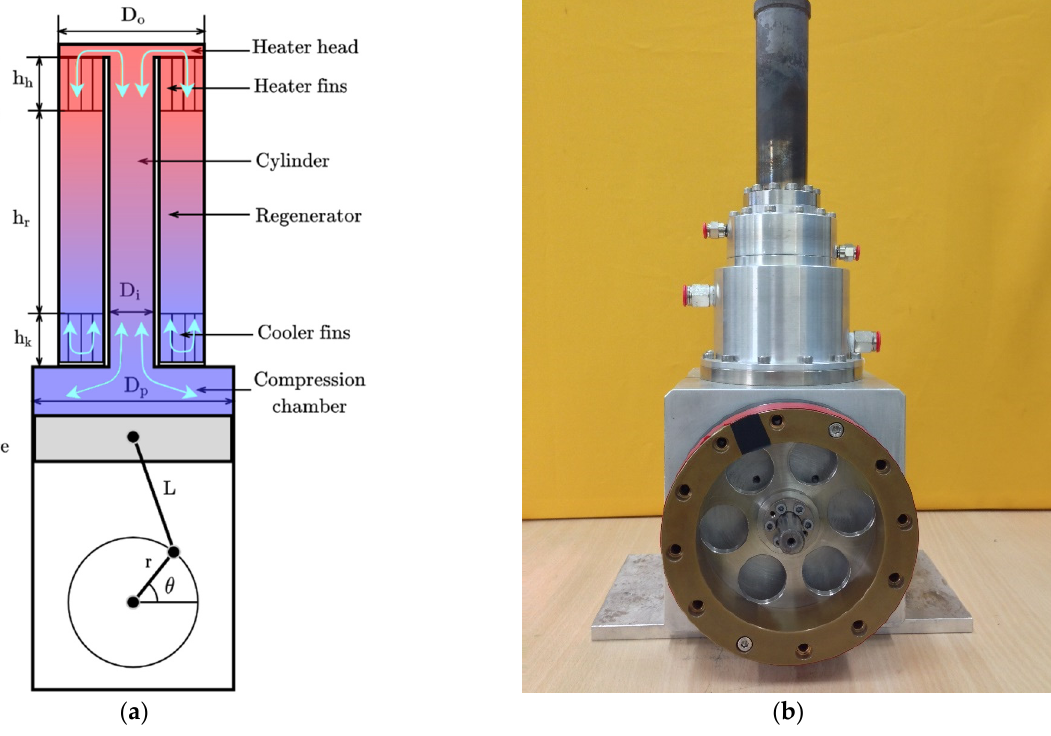
Figure 1. Prototype thermal-lag engine ( a ) Schematic diagram; ( b ) Prototype engine developed in PEACE Lab., NCKU